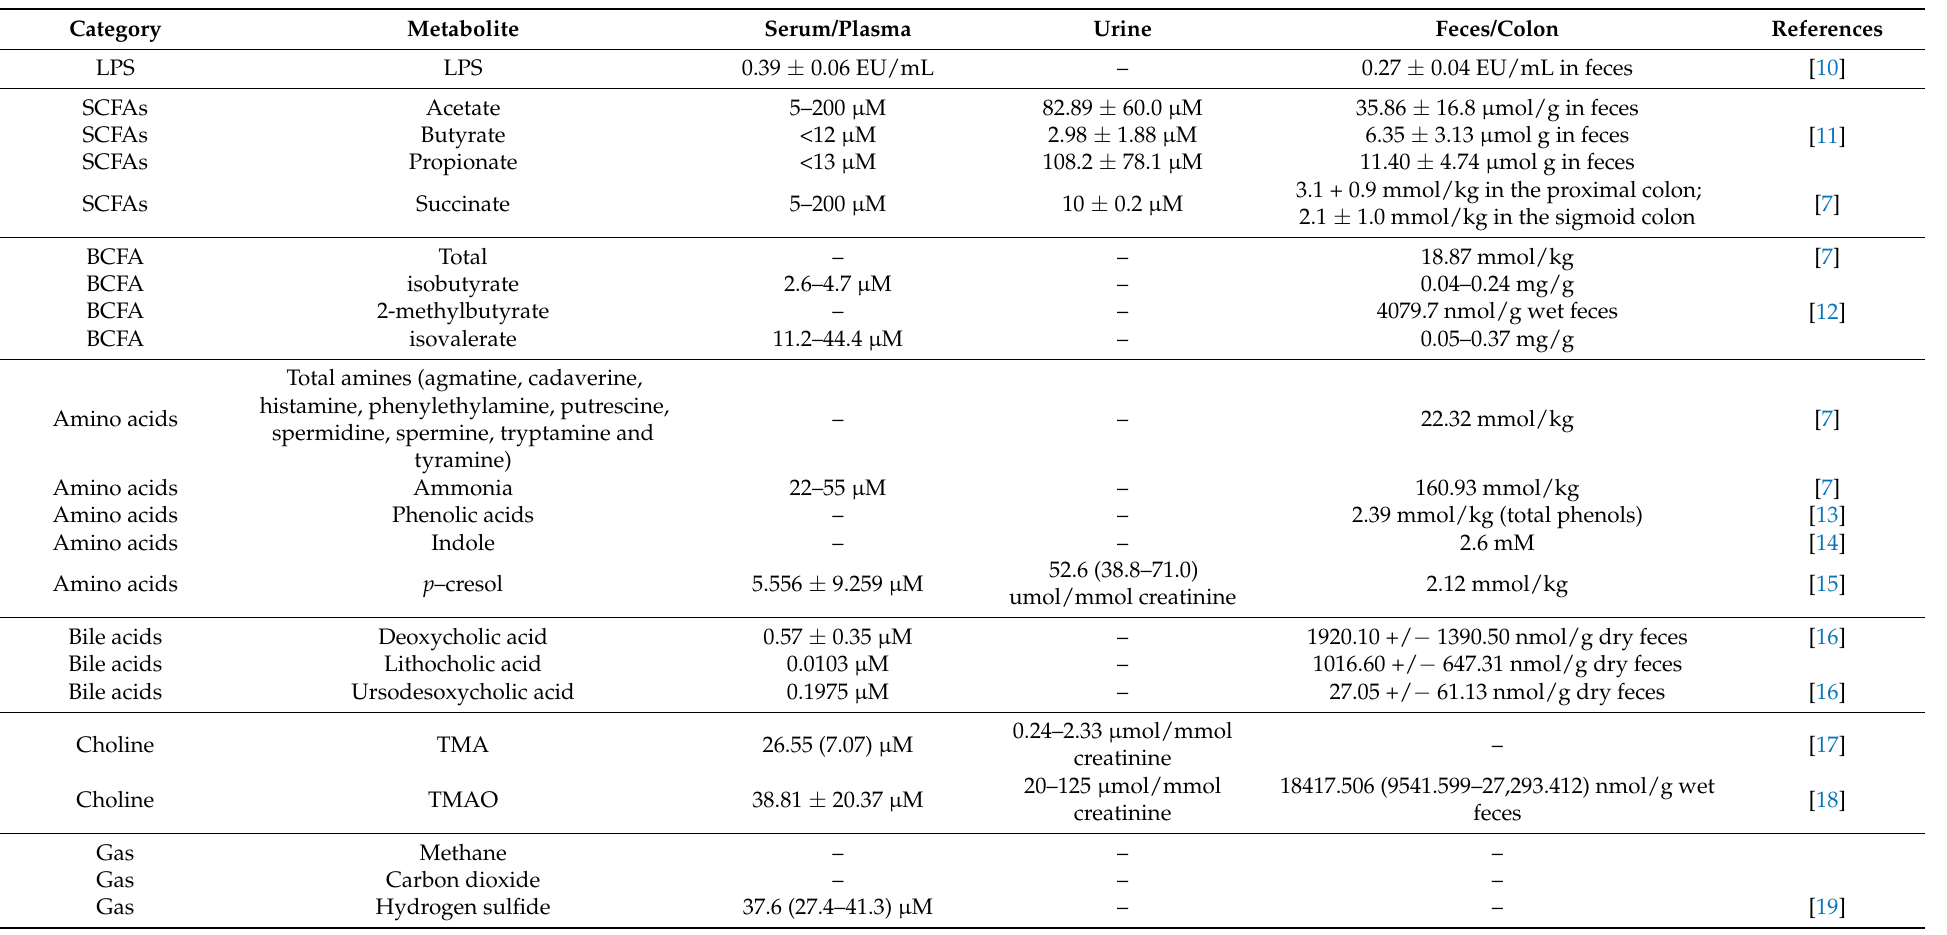
Table 1. Concentrations of gut microbial metabolites in human healthy